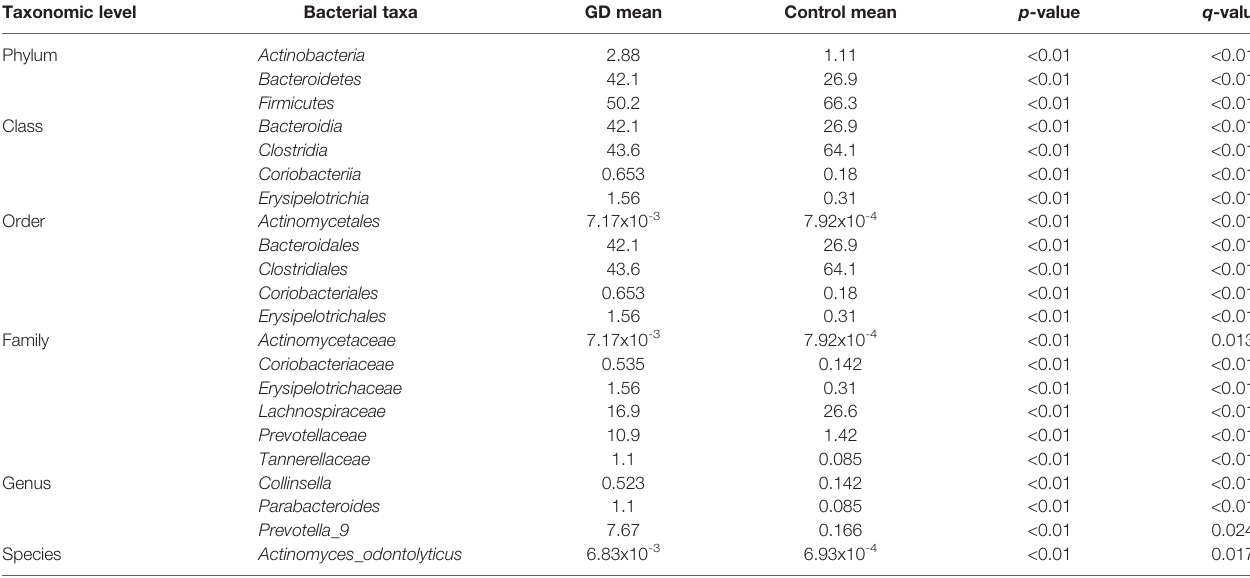
TABLE 3 | Signi fi cant differences in taxa abundances from phylum to species level between GD patients and healthy controls. Taxonomic level Bacterial